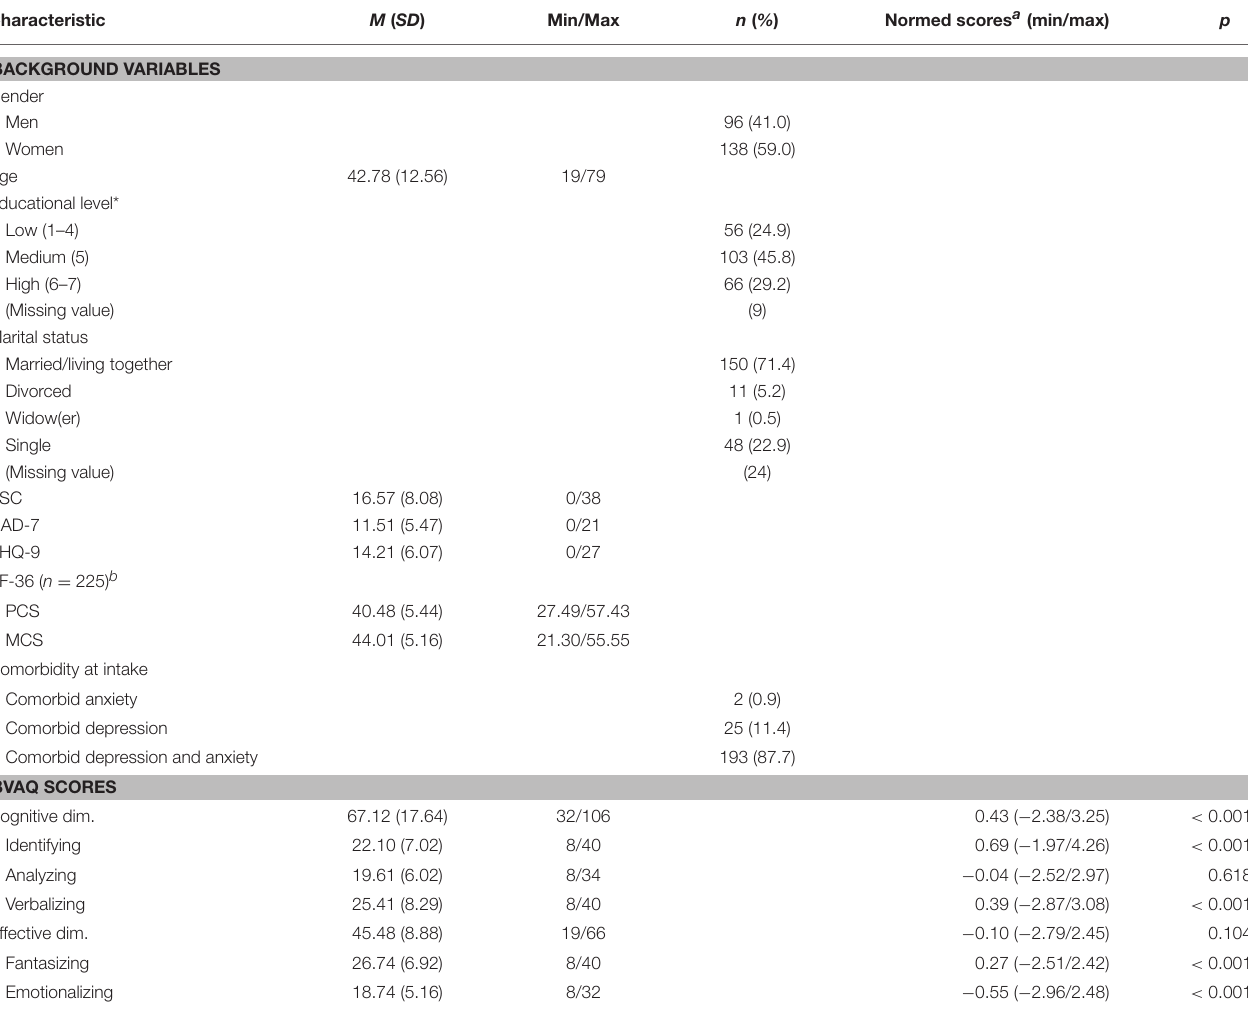
TABLE 1 | Socio-demographic characteristics and descriptive statistics for the BVAQ in the SSRD sample at intake ( N = 234).